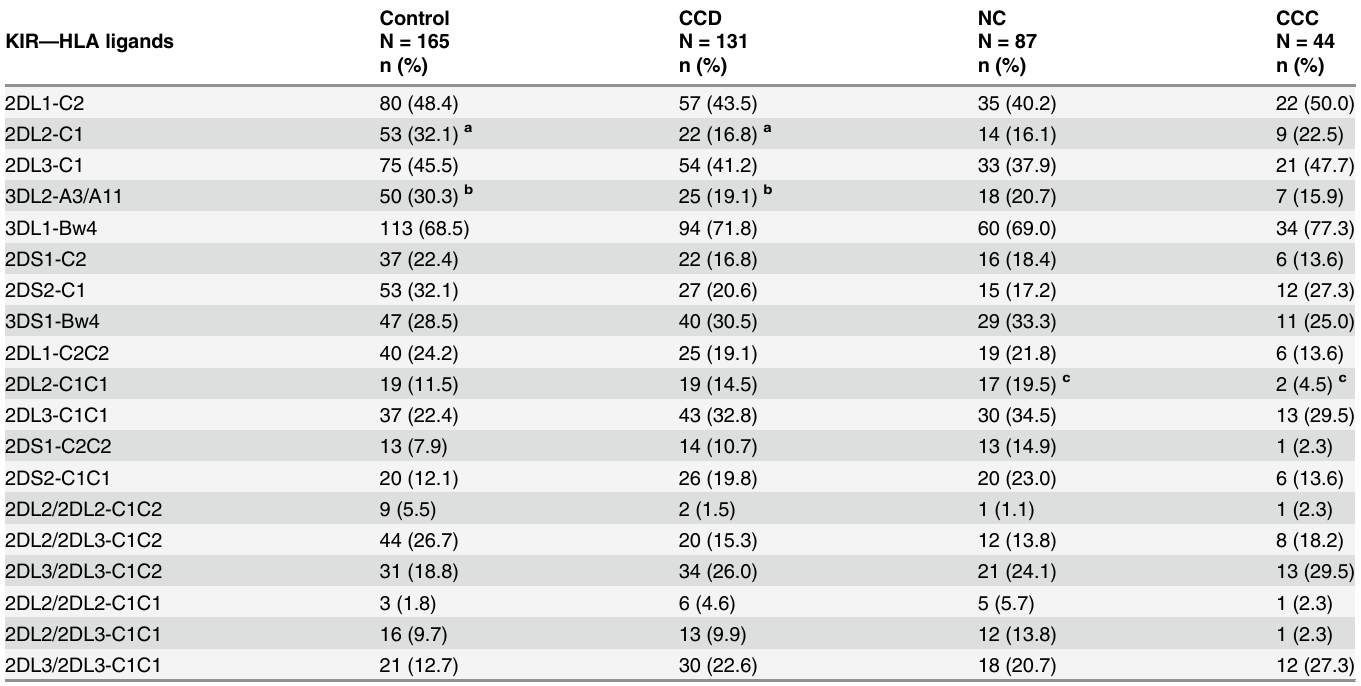
Table 3. Distribution of KIR and their respective HLA ligands in Chagas disease patients and controls.